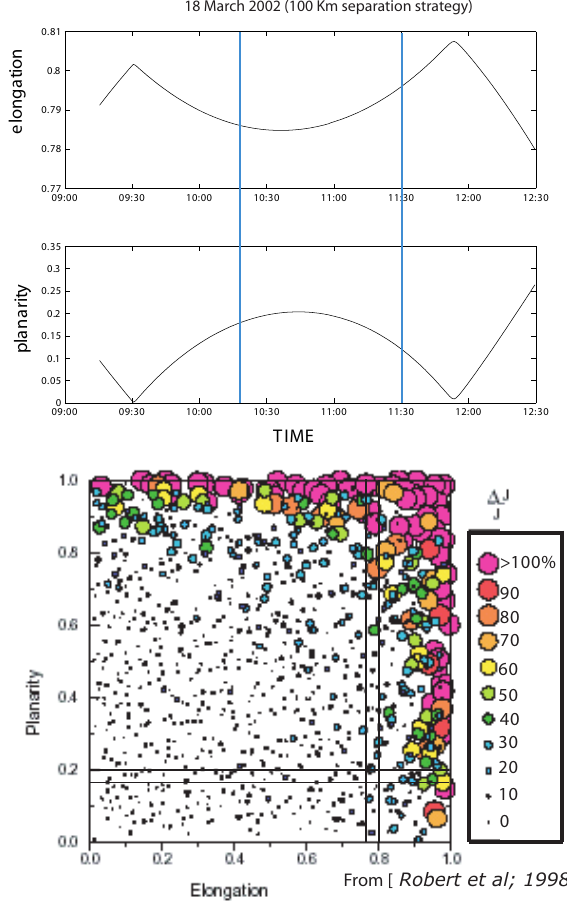
Fig. 1. Cluster spacecraft tetrahedron parameters for the 18 March 2002 perigee pass (upper panels), during which the spacecraft sep- aration strategy was 100km. The two blue vertical lines delimit the ring current traversal by the spacecraft. Bottom panel shows results of the study made by Robert et al. (1998b), which evaluated the in- fluence of the tetrahedron shape (characterised by the tetrahedron parameters) on the estimate of | J | . Black lines demarcate the ex- treme values taken by the two parameters for spacecraft separation distances during the 18 March 2002 ring current interval. This sepa- ration can go up to 250km at perigee, due to the keplerian evolution of the orbit (acceleration of the leading spacecraft). We can notice that the maximum uncertainty on | J | is never more than 20%.